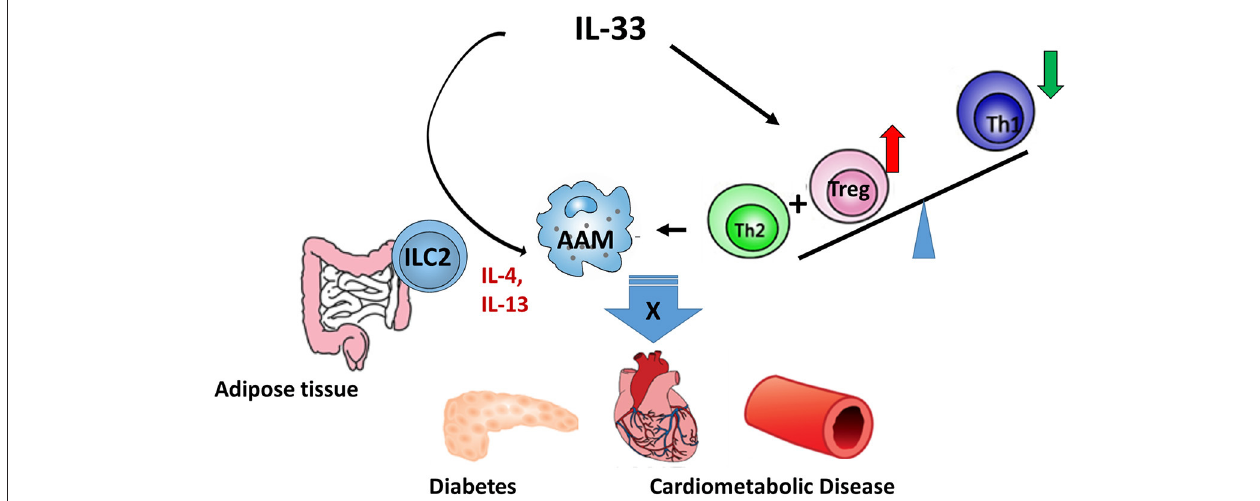
FIGURE 1 | The regulatory role of IL-33 in metabolic diseases. IL-33/ST2 axis regulates metabolic diseases through: (1) promoting AAM polarization; (2) regulating the differentiation and functions of Treg and Th2; and (3) regulating the function of ILC2.